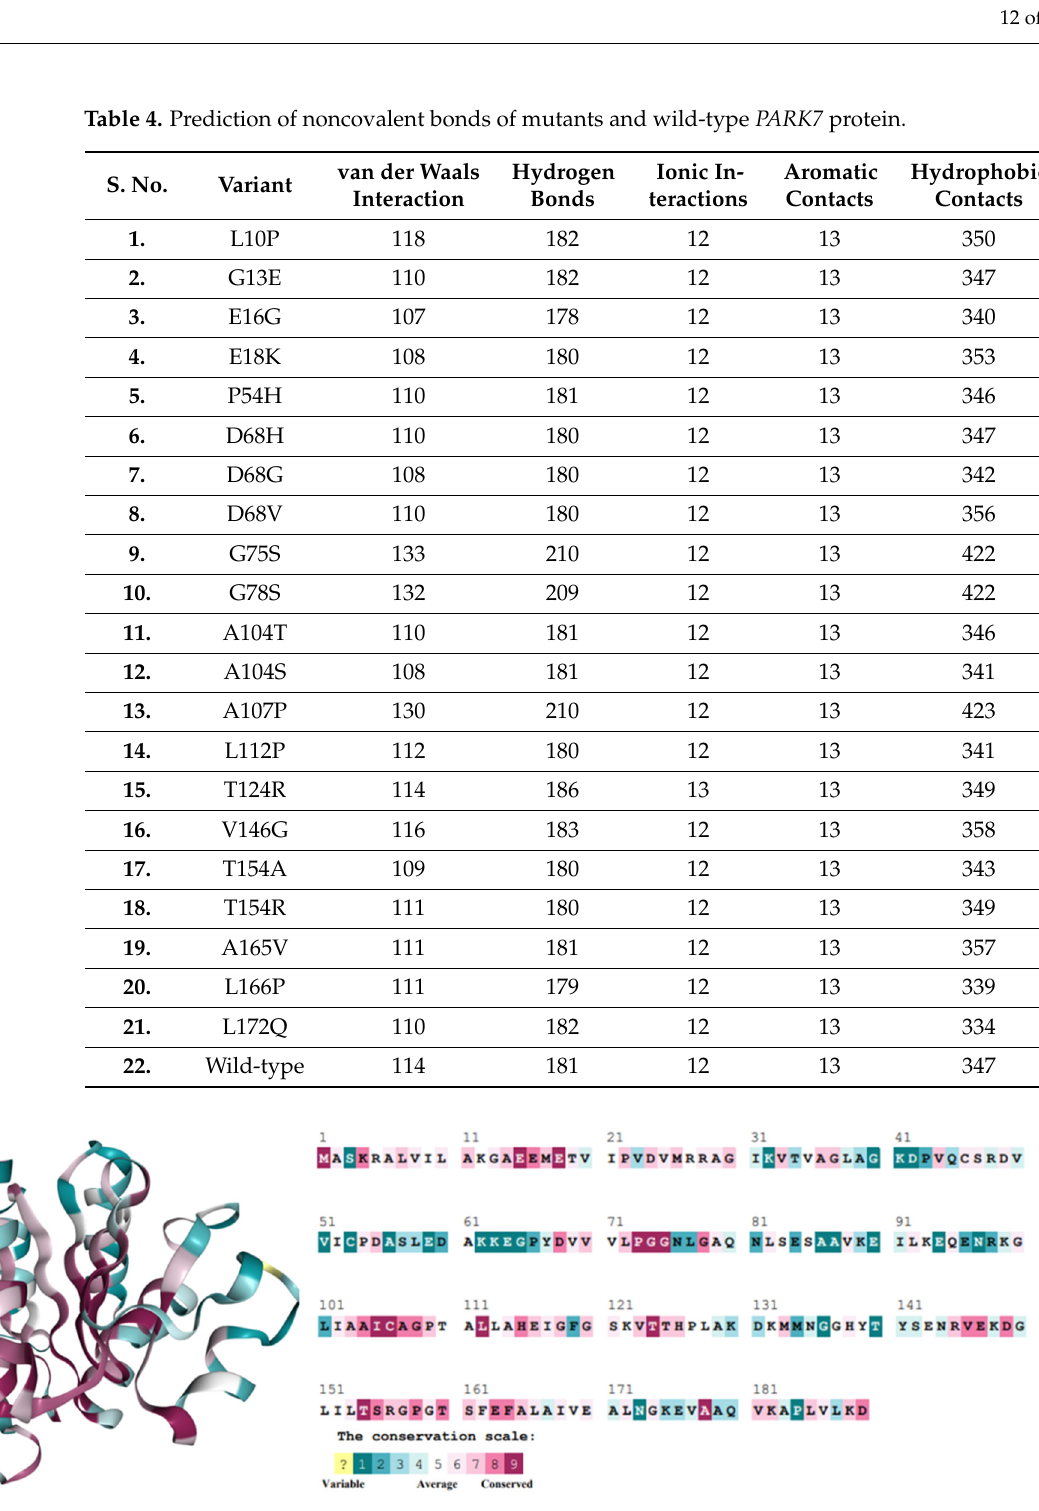
Figure 5. ConSurf plot showing residual conservation in the PARK7 structure and sequence.